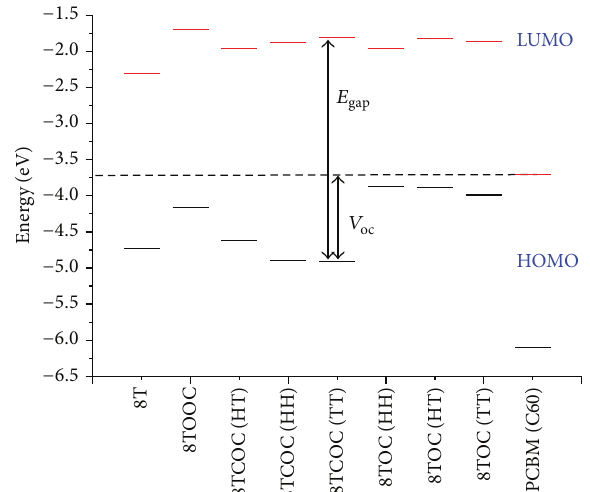
Figure 6: Band structure diagram illustrating the HOMO and LUMO energies of the studied compounds relative to the band structure of